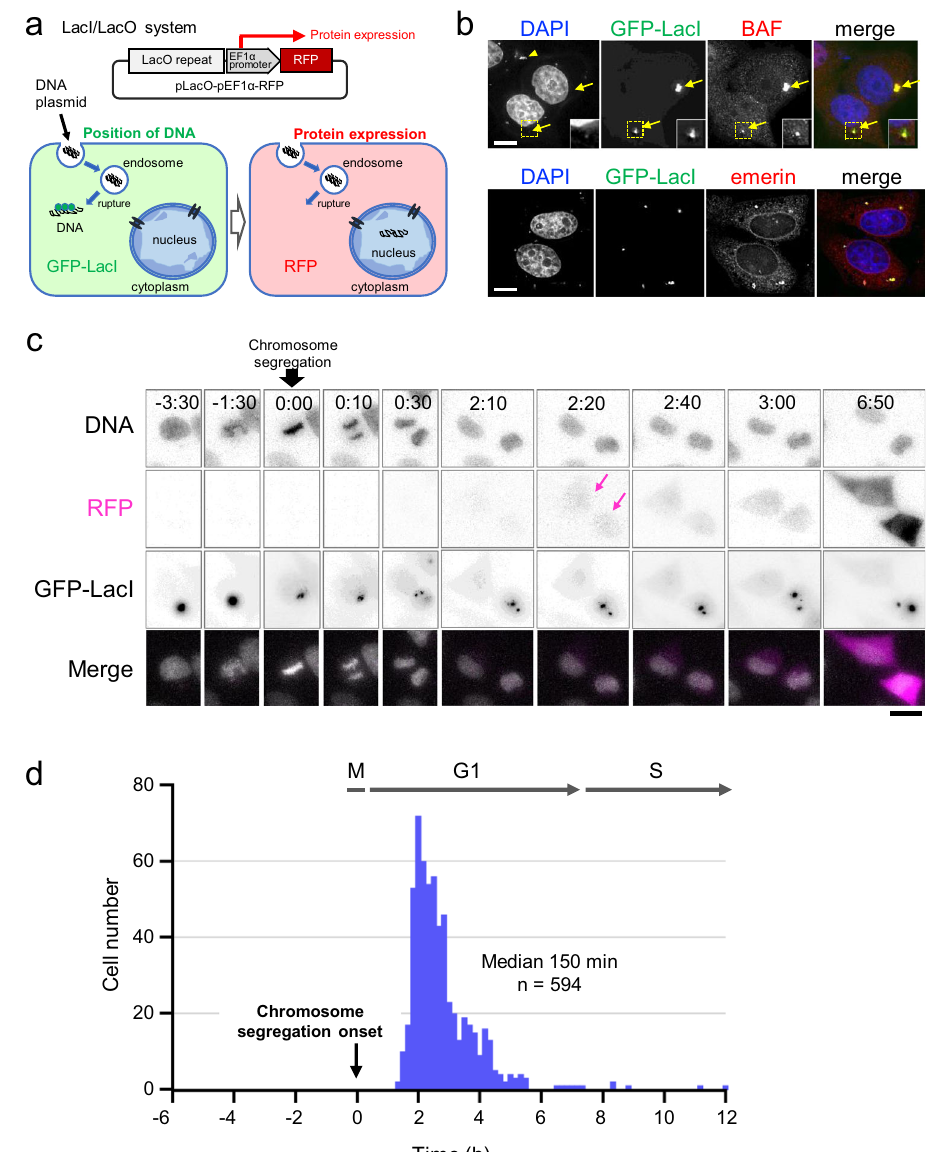
Fig. 1 Gene expression from foreign DNA occurs after mitosis. a Schematic of the experiment. Top: diagram of pLacO-pEF1 α -RFP. This plasmid carries a lacO repeat sequence (256 repeats, approximately 10 kbp) and a sequence expressing a monomeric red fl uorescent protein (RFP) under the EF1 α promoter. Bottom left: when the transfected plasmid is exposed to the cytosol upon endosome rupture, it binds to GFP-LacI and becomes fl uorescent. Bottom right: when it enters the nucleus, the expression of RFP occurs. Therefore, RFP fl uorescence is an indication of the nuclear translocation of the plasmid. While using this system, exogenous gene expression was determined by the appearance of RFP fl uorescence. b HeLa/GFP-LacI cells transfected with pLacO- pEF1 α -RFP (0.5 μ g/dish) diagrammed in a . Immediately after transfection, the cells were fi xed and stained using anti-BAF or anti-emerin antibodies. DNA (stained with DAPI, blue), GFP-LacI (green), and BAF (red) or emerin (red) in the merged image. Arrows indicate DAPI signals with GFP-LacI signals. Arrowhead indicates DAPI signals without GFP-LacI signals. The inset shows an image with increased brightness in the boxed region. Bar, 10 μ m. c Time- lapse live-cell images of transfected HeLa/GFP-LacI cells. DNA was stained with Hoechst 33342 to determine the timing of chromosome segregation. Immediately after transfection, acquisition of time-lapse images at 10-min intervals was started. Selected time frames are shown. Images at each time frame are maximum intensity projection images for z -stacks. The numbers represent time (h:min). Time 0 represents the onset of chromosome segregation. Merged images, DNA (Hoechst 33342, white) and RFP (magenta). Bar, 20 μ m. d Timing of protein expression from transfected DNA. The timings of RFP expression and chromosome segregation were determined in individual cells by time-lapse live-cell imaging as described in c . X axis represents the time of RFP expression in hours when the timing of chromosome segregation was set to zero for each cell. Y axis is the number of cells that expressed RFP at that time. Cell numbers plotted were n = 248 by DV and n = 346 by LSM880; total number, n = 594. These data are combined in this graph.